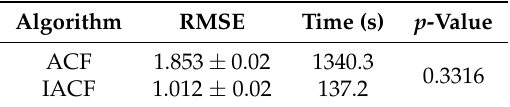
Table 1. Rating-based recommendation results evaluation.